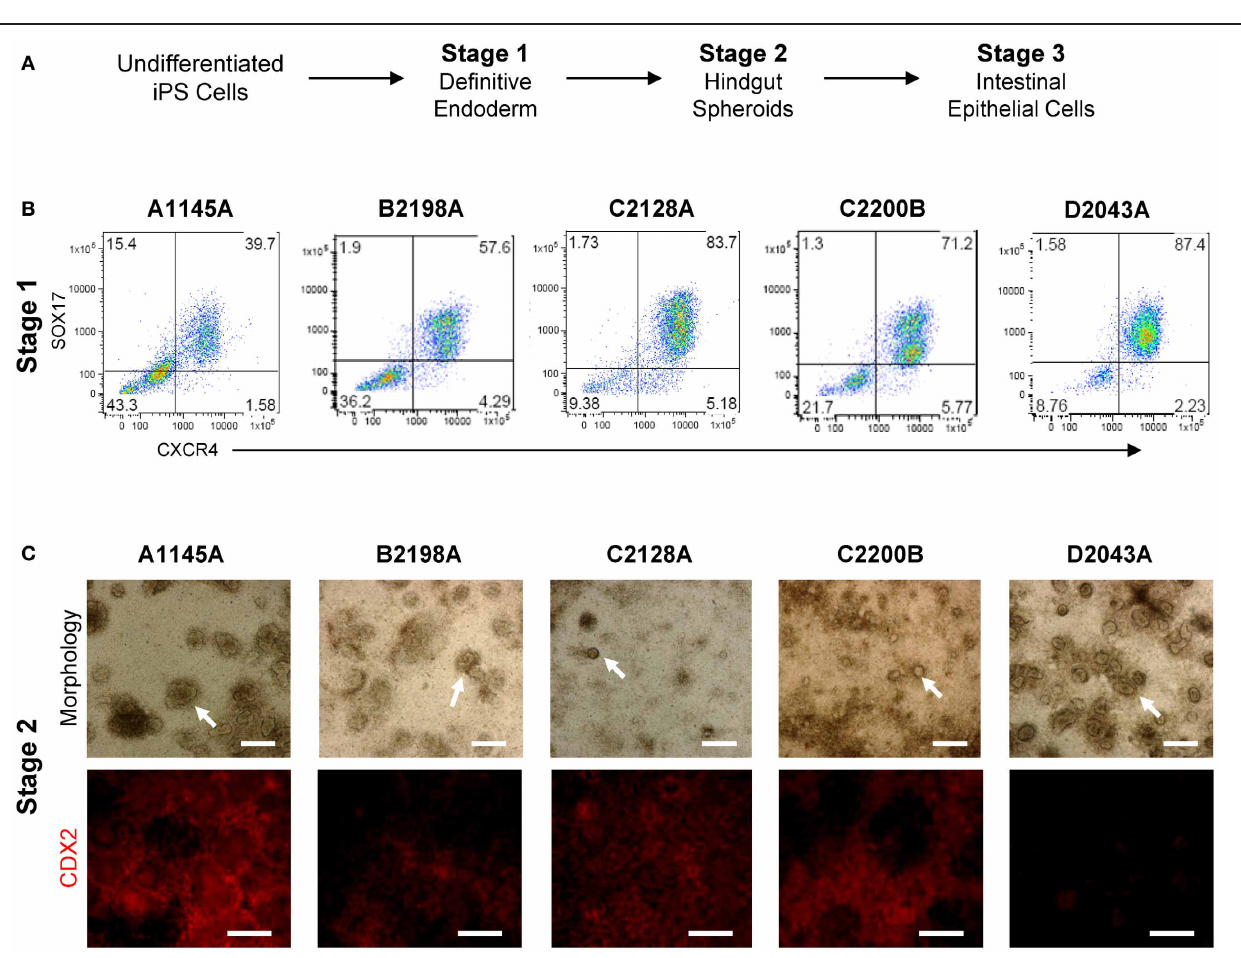
FIGURE 3 | iPSC directed intestinal differentiation in transwell culture results in cells with expected morphology and marker expression through Stage 2. (A) Directed intestinal differentiation occurs through several distinct stages. (B) Transwell cells derived from a panel of iPSC lines express Definitive Endoderm markers SOX17 and CXCR4 at